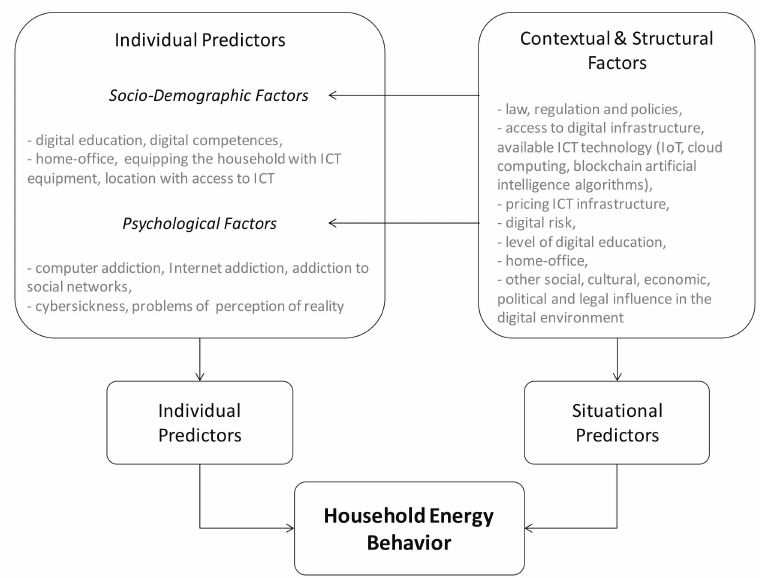
Figure 1. Household energy behavior in the digital era main